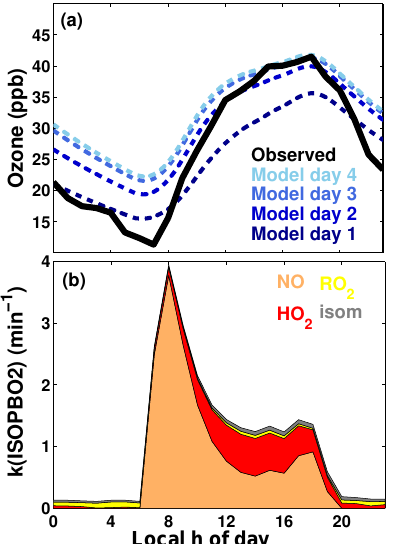
Figure 5. (a) Progression of a simulated diurnal ozone profile (dashed lines) over 4 days of a constrained boundary layer diurnal cycle simulation (Sect. 3.3). Observed ozone is also shown (solid black line). (b) Reactivity of a representative first-generation iso- prene hydroxyperoxy radical against reaction with NO (orange), HO 2 (red), other RO 2 (yellow) and 1.5 H-shift isomerization. Rates are taken from the final simulation